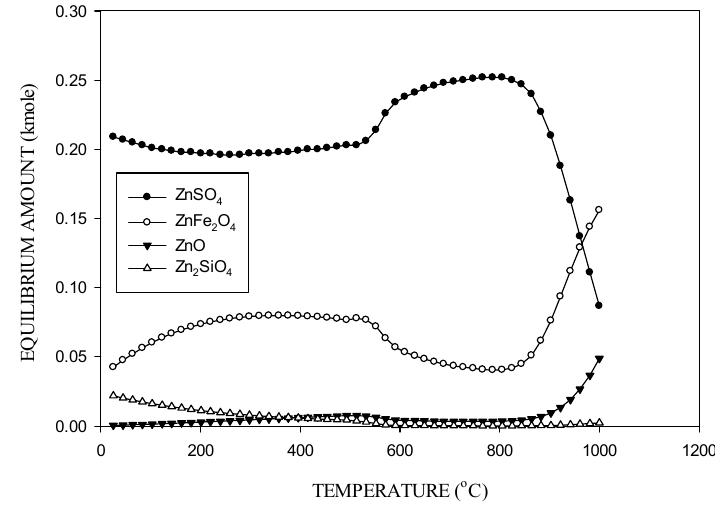
Figure 3. Equilibrium amounts of the zinc-containing species as a function of the temperature for the addition of 0.68 kmole SO 2 /100 kg of dust and 0.34 kmole O 2 /100 kg of dust.